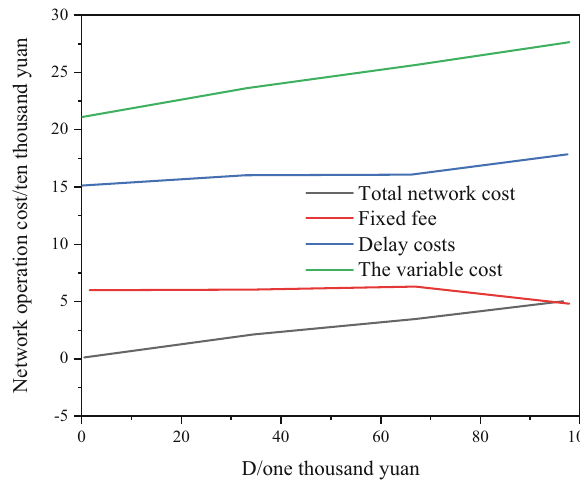
Figure 6: Computer simulation results of di ff erent variable cost weighting coe ffi